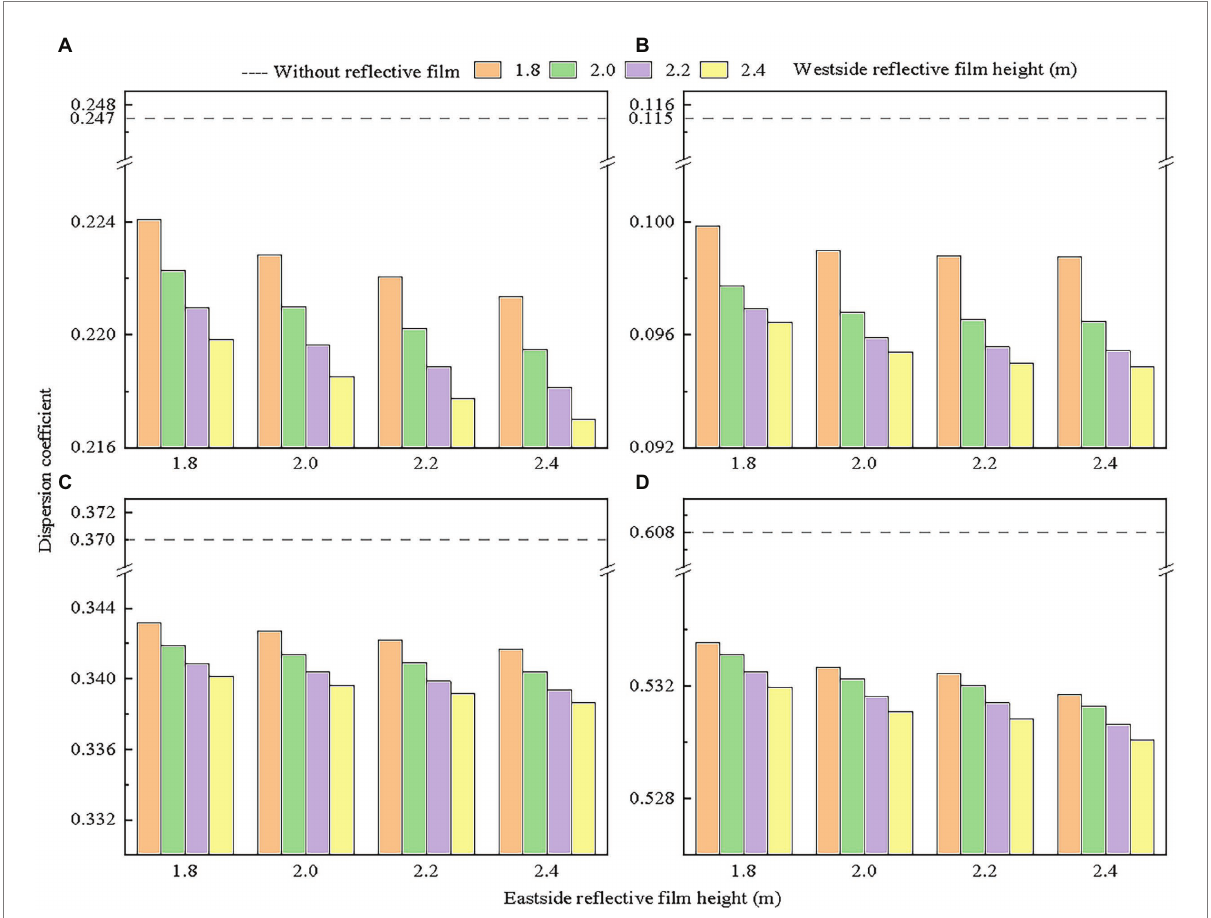
FIGURE 11 Effects of height of reflective films located on the east and west sides of the greenhouse on light distribution of: (A) total canopy, (B) upper canopy, (C) middle canopy, and (D) lower canopy compared to scenario without reflective films. The height of the reflective film under canopy was fixed at 0.1 m.